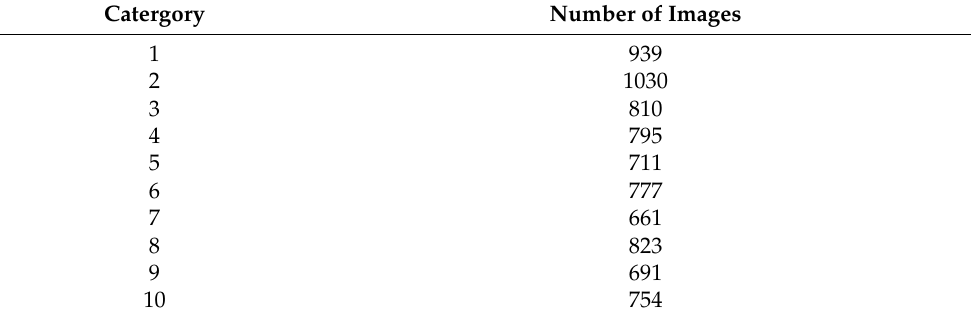
Table 1. Typical images